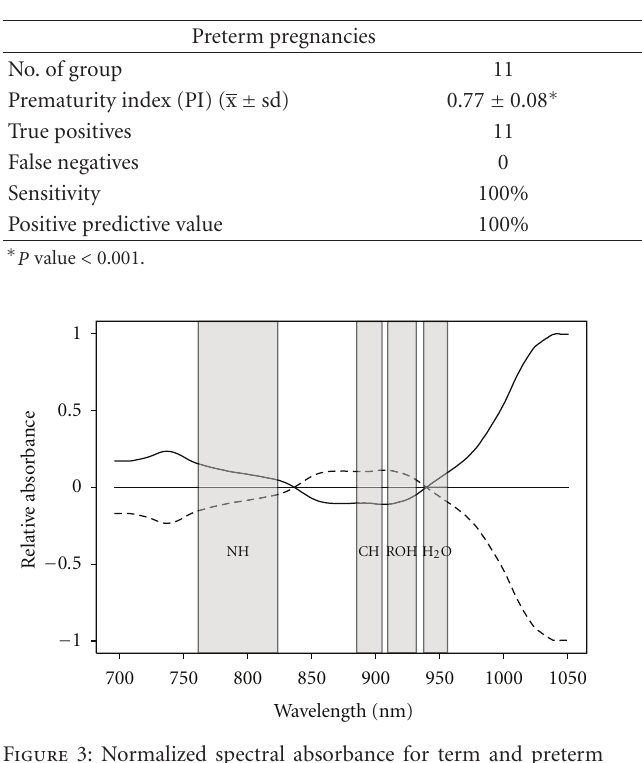
Table 2: Results for the cross-validation of the calibration model and diagnostic statistics.